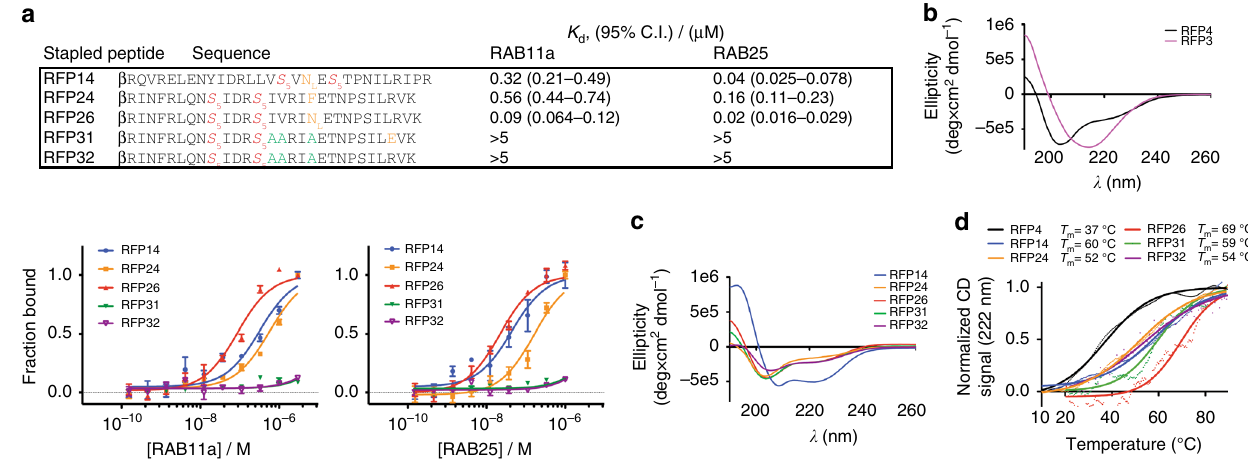
Fig. 2 Optimized stapled peptides targeting RAB25 show correlated structural stability and high-af fi nity binding. a Fluorescence polarization binding curves for three lead compounds, RFP14, 24, and 26, as well as two negative control peptides, RFP31 and 32, to both RAB11a and RAB25 ( bottom ). Sequences and calculated apparent K d values are shown ( top ). Residues highlighted in yellow denote potential gain-of-function mutations to RAB-binding positions, while those in green denotes loss-of-function alanine replacement of hydrophobic RAB-binding side chains for the negative controls. b Circular dichroism (CD) spectra of unmodi fi ed peptides derived from the RBD of FIP3 and FIP4. c CD spectra of optimized RFP stapled peptides. d Thermal denaturation CD curves measuring relative helical content (CD absorbance at 222 nm) of the indicated peptides over a temperature range from 10 to 90 °C. Individual data points at one-degree increments are shown with a sigmoidal curve fi t overlay. Binding data points represent the mean ± s.e.m. from triplicate measurements. Af fi nities listed represent the mean apparent K d with 95% con fi dence interval from triplicate replicates and application of a sigmoidal curve fi t using